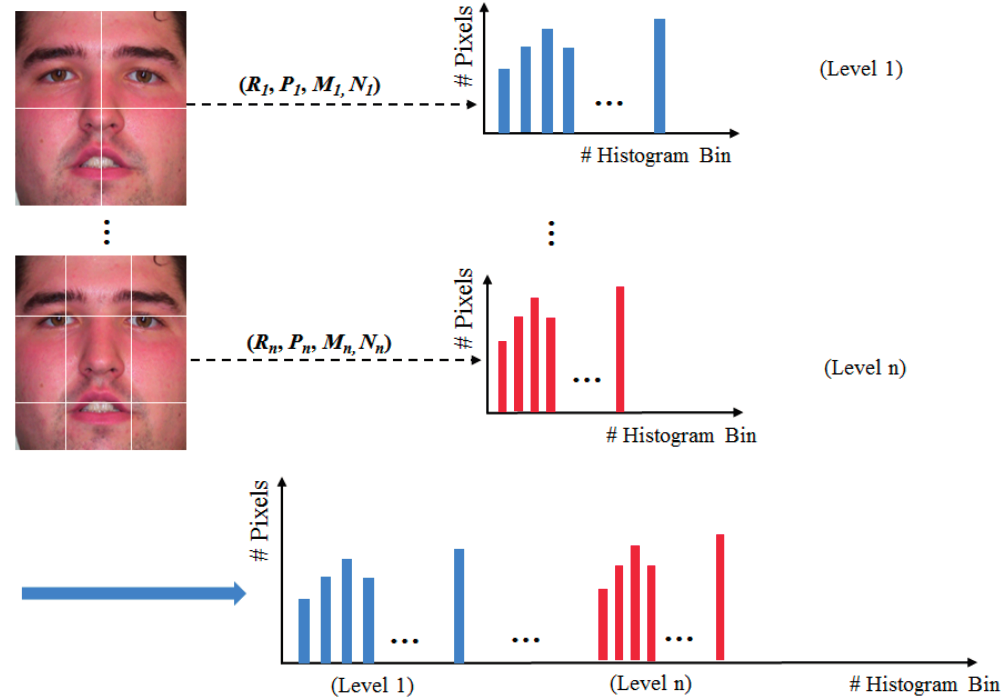
Figure 14. Methodology for feature extraction using MLBP